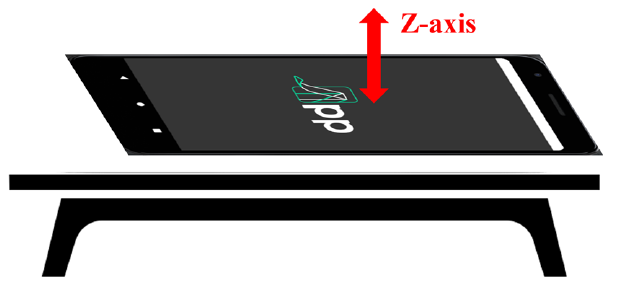
Figure 1. Measurement axis used in the application.